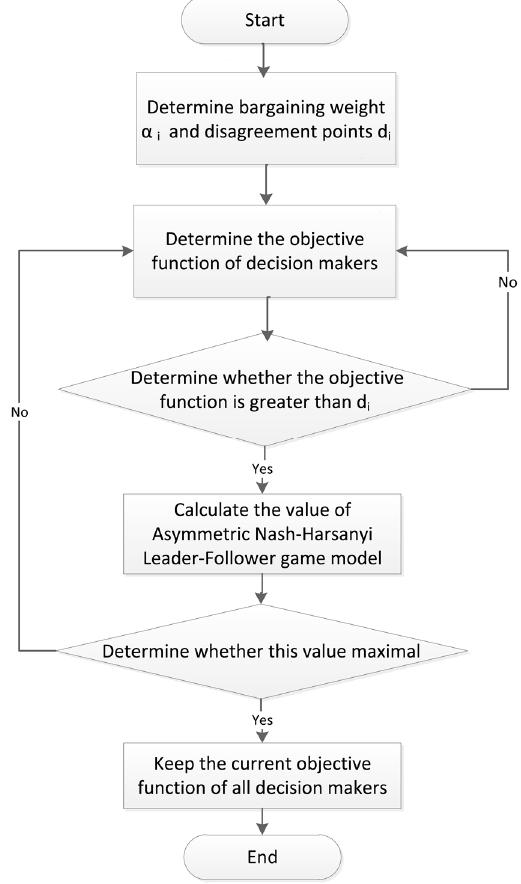
Figure 1. The solution steps of the asymmetric Nash–Harsanyi game model.